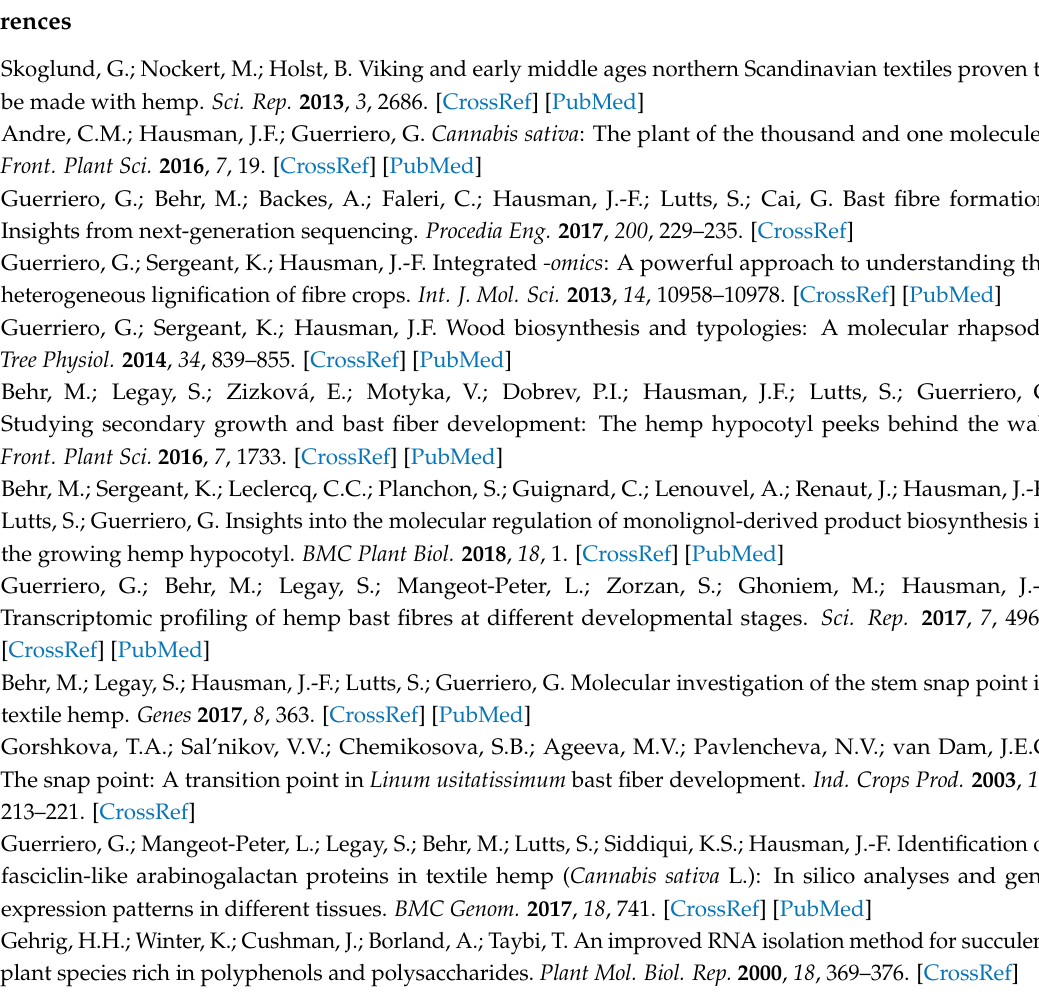
Table S1: Primers and raw gene expression